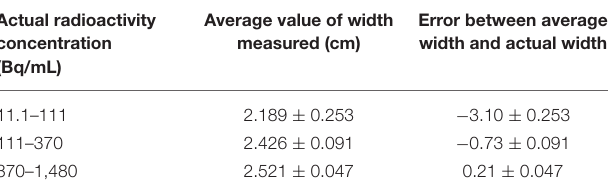
TABLE 2 | Comparison of container width measured by R50 method with actual width